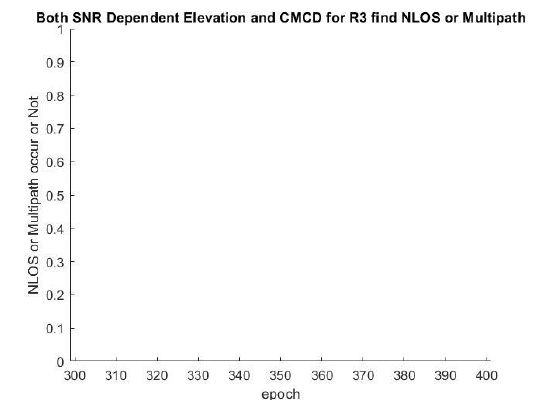
Figure 19. Both SNR Dependent Elevation and CMCD find NLOS or Multipath for R3 (In this period, the results of these two indicators were not similar.)